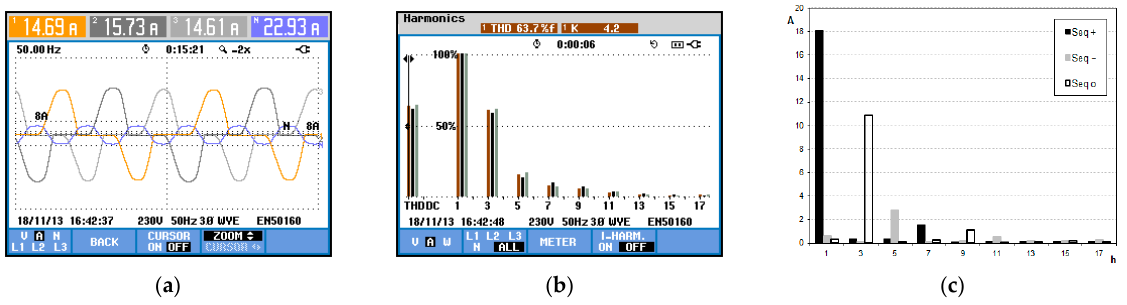
Figure 27. Case 1 - system without filters: ( a ) three-phase currents; ( b ) harmonic spectrum of the currents; ( c ) harmonic spectrum of the current sequence components (maximum values).